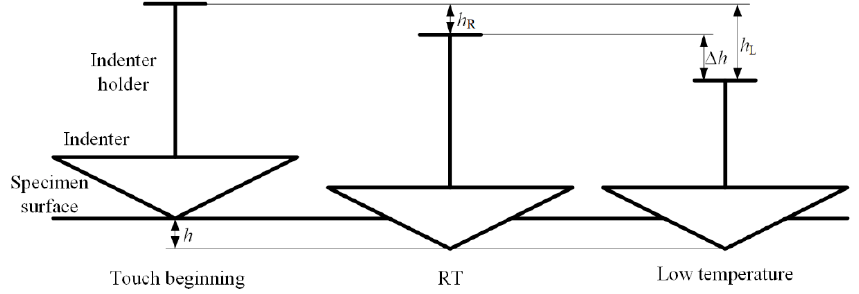
Figure 11. Occurrence of contact drift during low temperature nanoindentation. RT—room temperature.